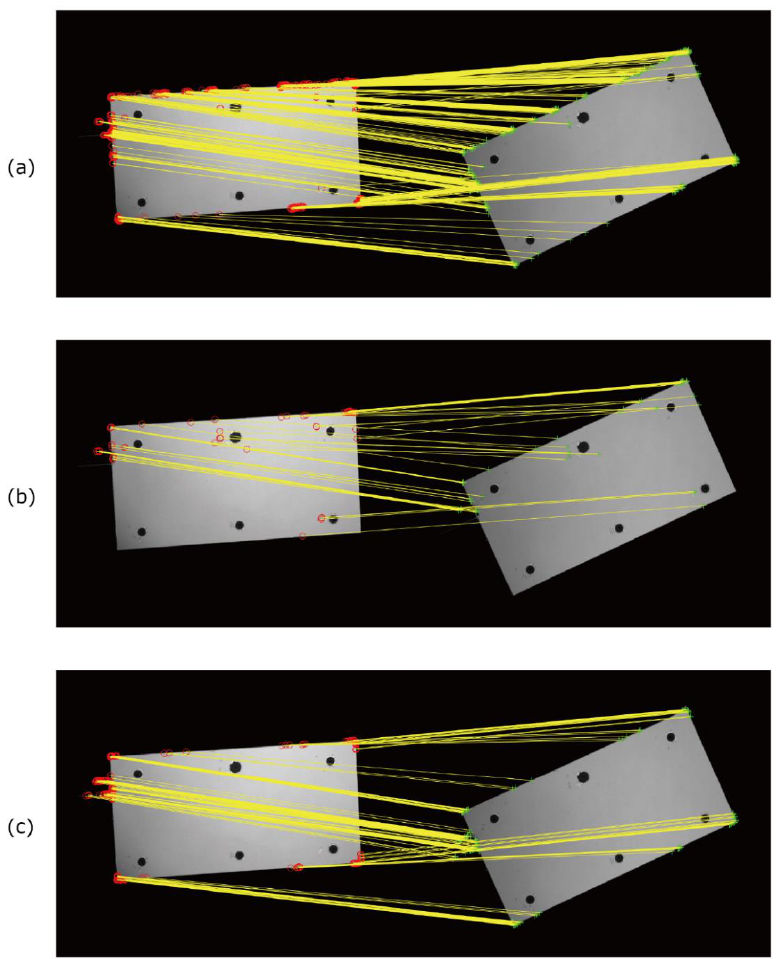
Figure 2. Results of feature point matching for obtained feature points by ( a ) the DoG detector, ( b ) the Hessian corner detector, and ( c ) the proposed method.